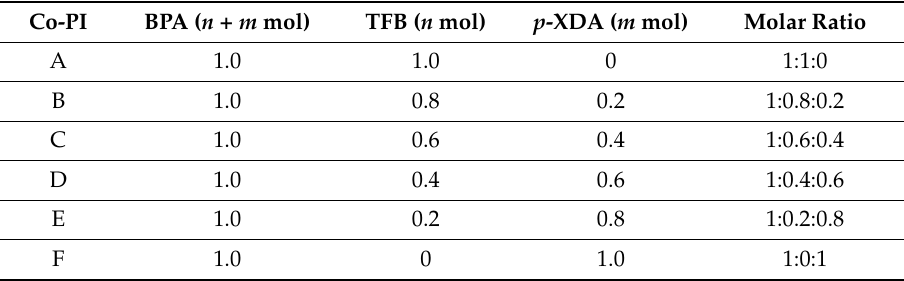
Table 1. Monomer compositions of the copolyimide (Co-PI) films.